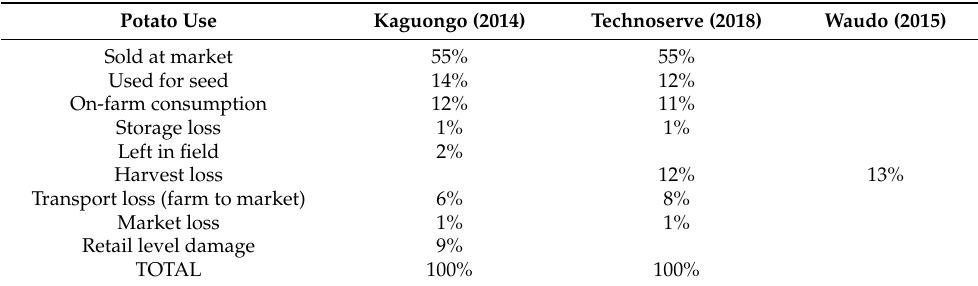
Table 4. Potato Use in Kenya Based on 3